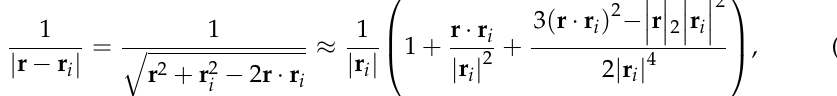
= . As in Figure 1, ec